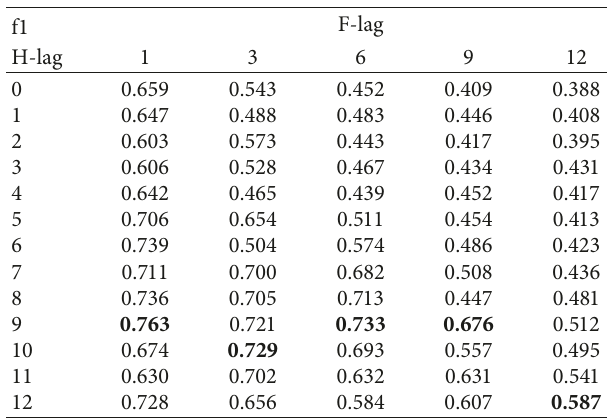
Figure 5: The LSTM network architecture used in this paper. Table 4: Influences of different historical time lag over different future time